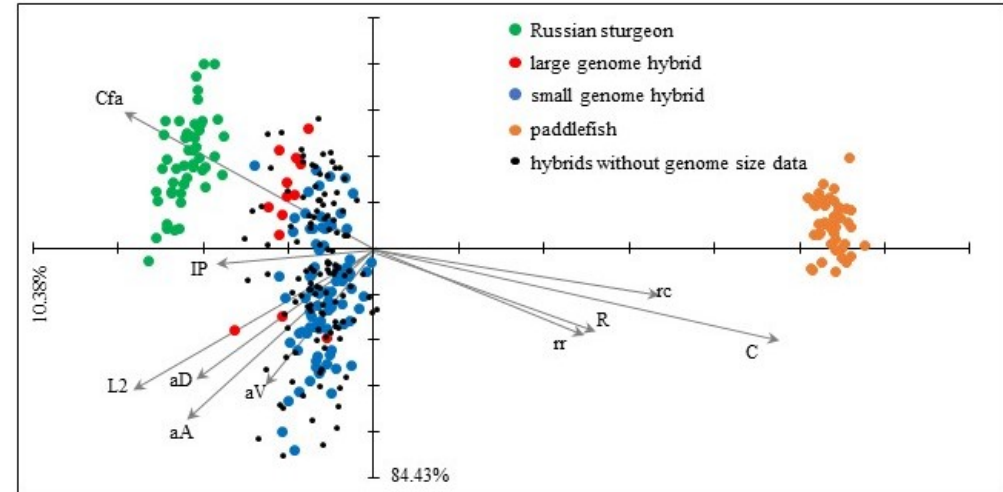
Figure 3. Principal component analysis (PCA) plot for morphometric characters. The percentage of total variance associated with each component is provided. Abbreviations: Cfa: length of the upper caudal lobe, IP: length of pectoral fin, L2: standard length, aD: predorsal distance, aA: preanal distance, aV: preventral distance, rr: snout length, R: preorbital length, C: head length, rc: snout tip–barbel base distance.